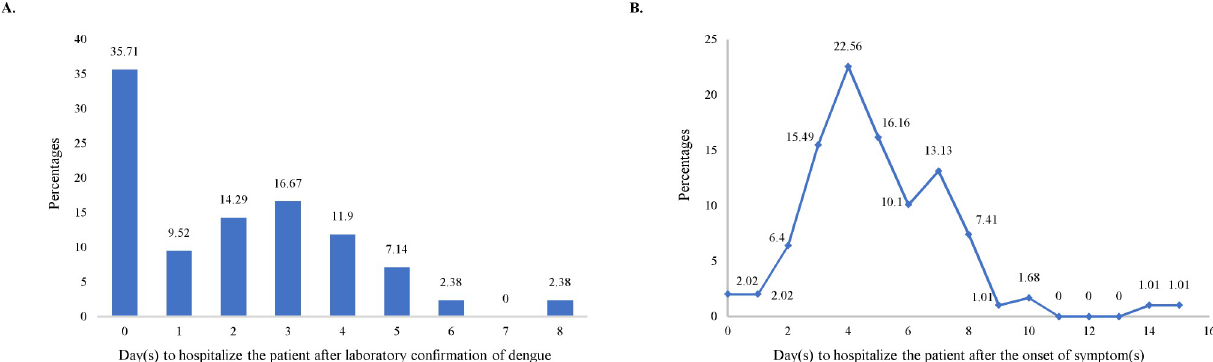
Fig 4. Association of the average recovery time of the patients with delay in the hospitalization. (A) Distribution of patients based on their delay in hospitalization after the confirmation of DENV infection, (B) Distribution of patients based on their delay in hospitalization after the onset of symptoms.